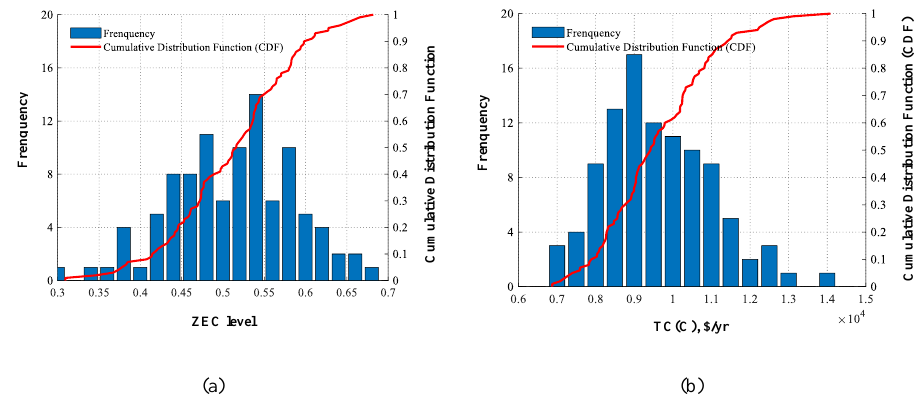
Fig. 5. (a) Distribution of ZEC level; (b) total cost of the